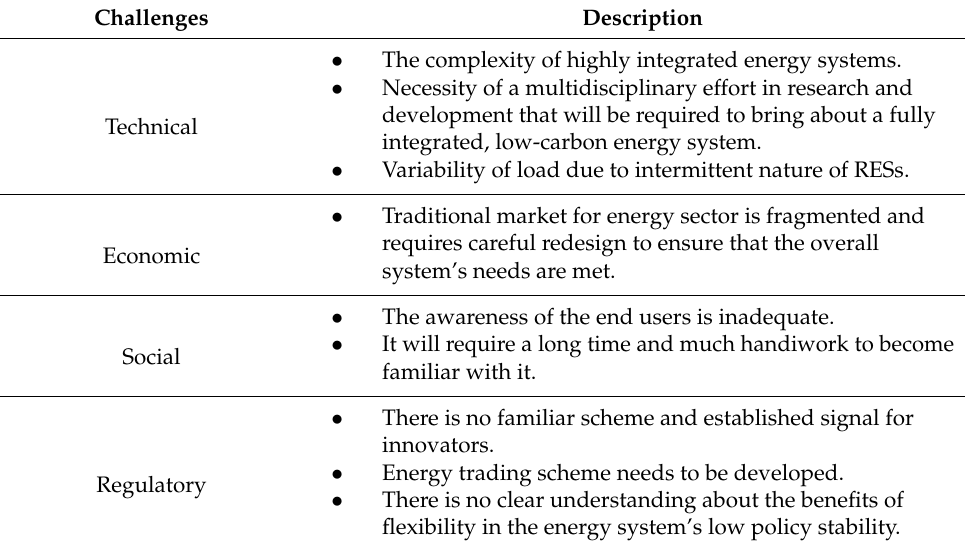
Figure 3. Challenges in multi-vector energy systems. Table 3. Description of multi-vector energy system challenges [37].